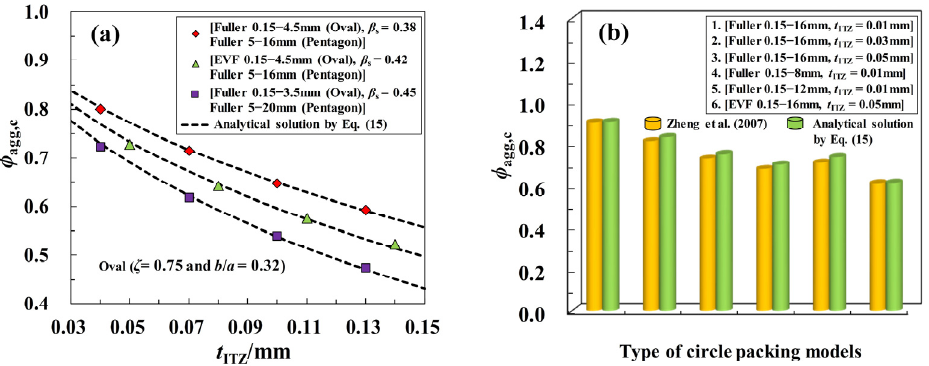
Figure 15. Comparisons of the numerical solutions of ϕ agg,c predicted by Equation (15) with ( a ) the simulated results of ϕ agg,c in some extra cases; ( b ) the reported results in [15].